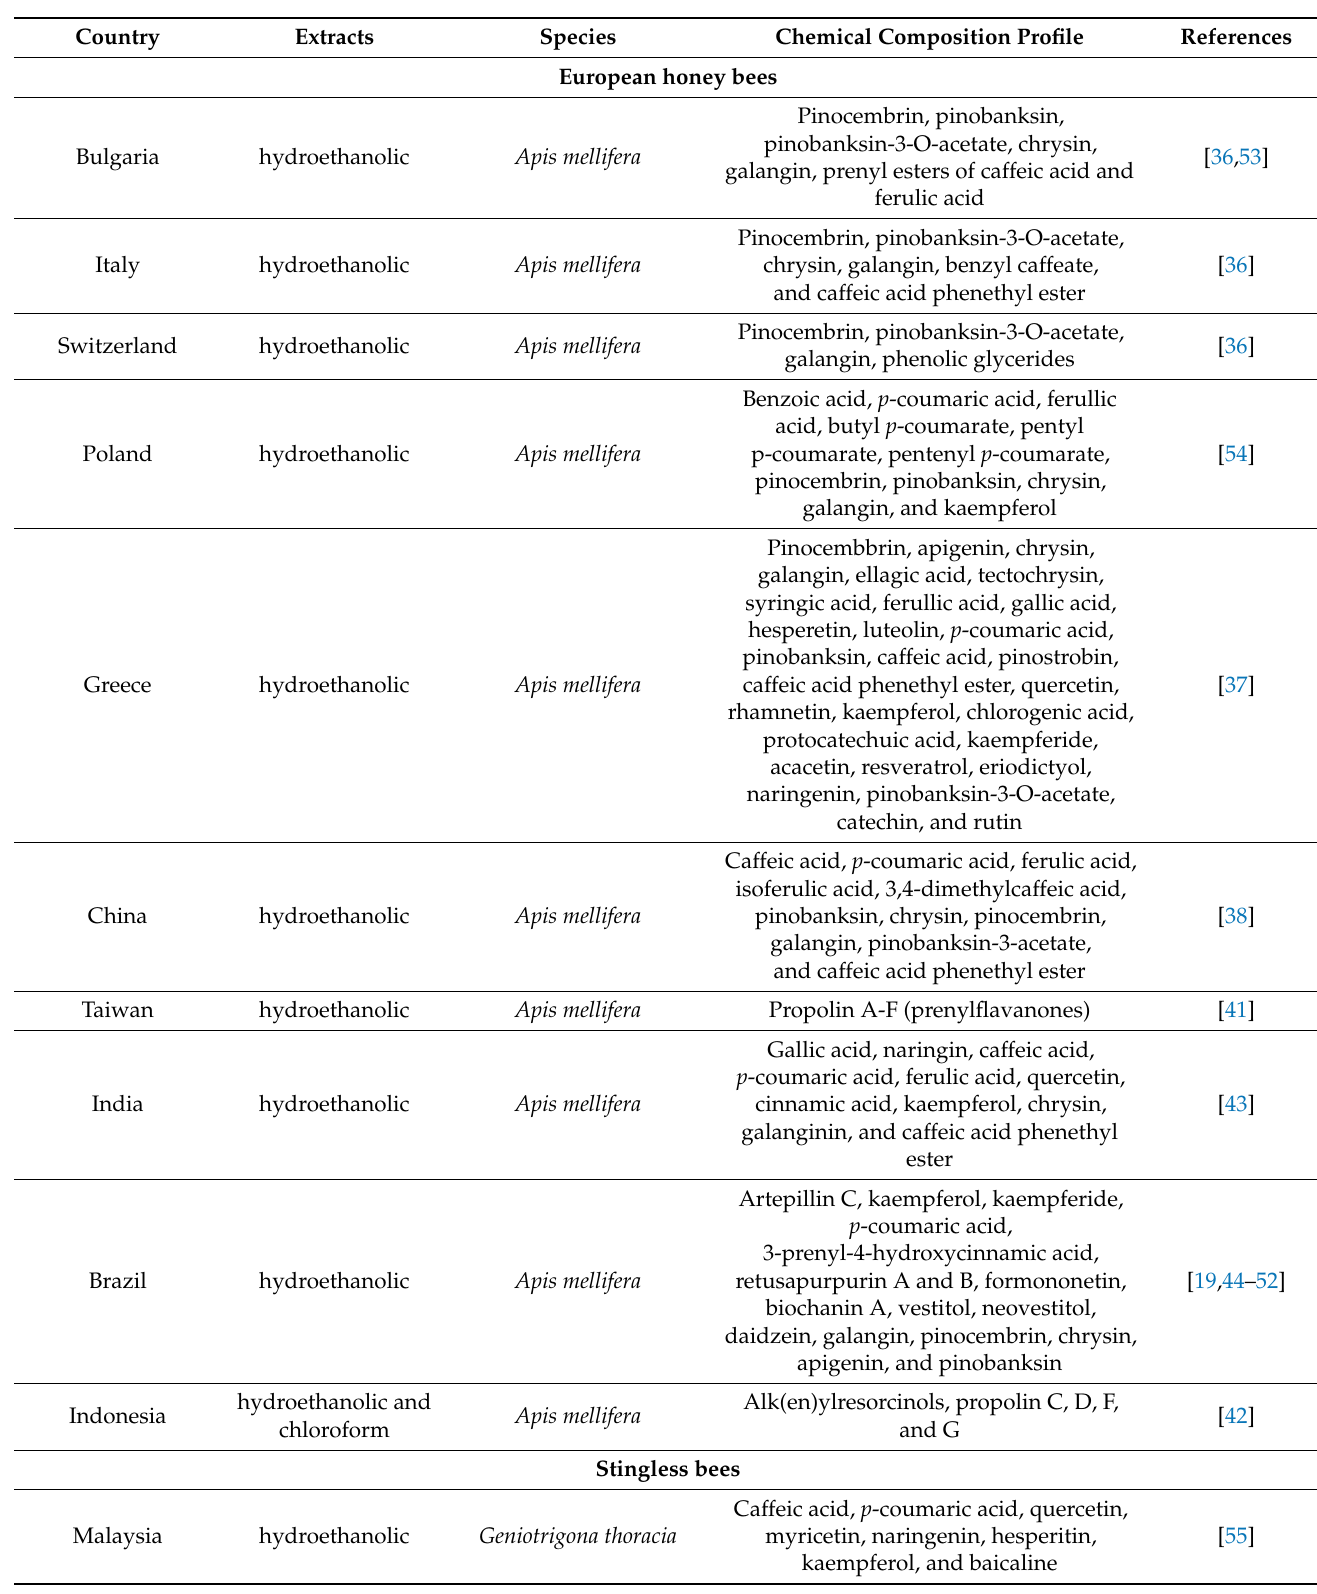
Table 1. The profile of phenolic compounds of propolis from various sources. These are for illustrative purposes only and by no means